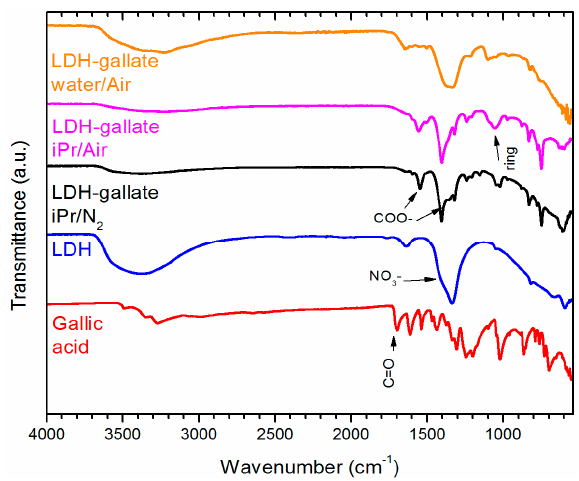
Figure 1. Infrared spectra of gallic acid, the layered double hydroxide (LDH) and the LDH-gallate products obtained from different environments.